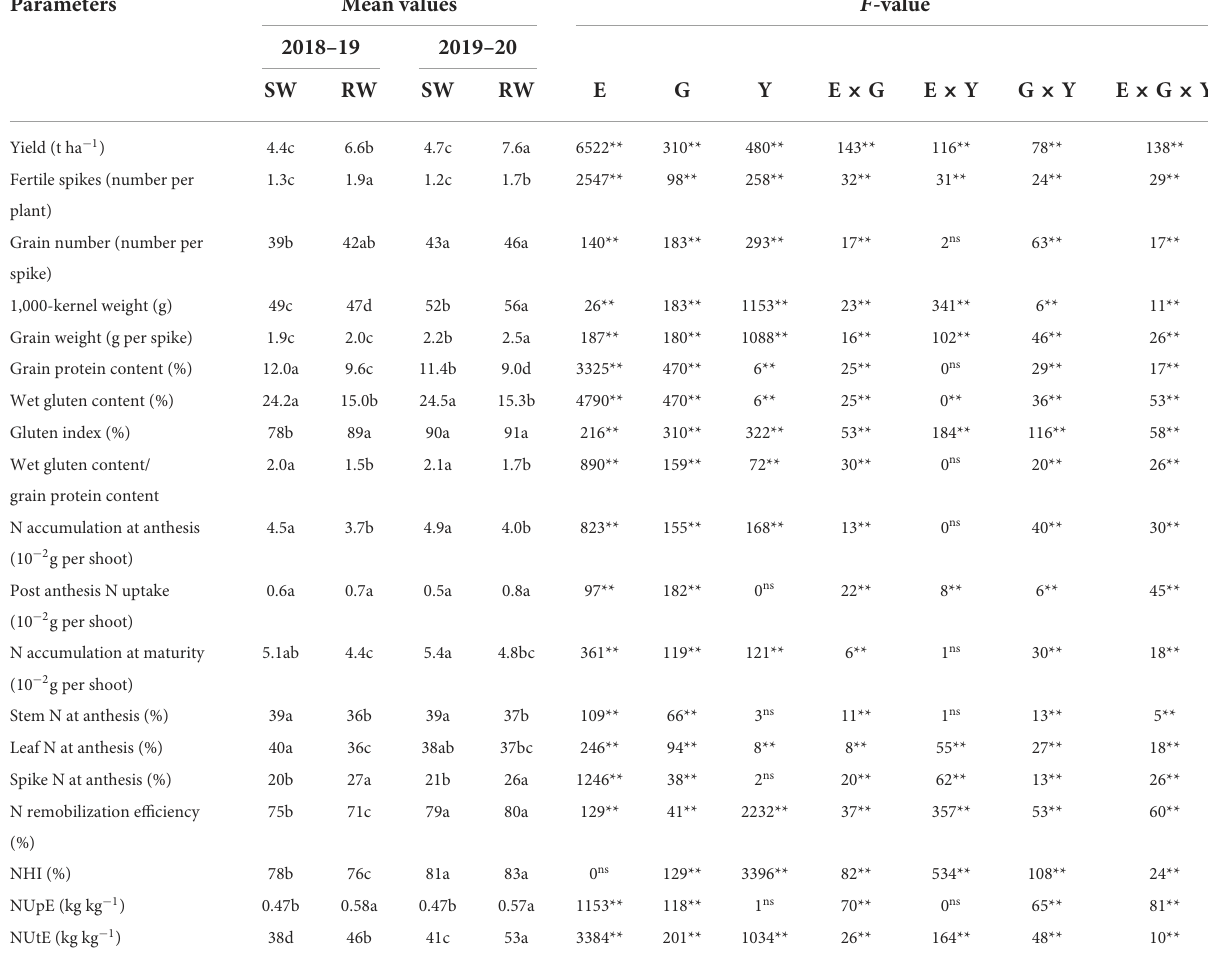
TABLE 2 Combined ANOVA on variations in grain yield, protein quality, nitrogen efficiency, and related traits in two wheat cropping systems and two cropping years.